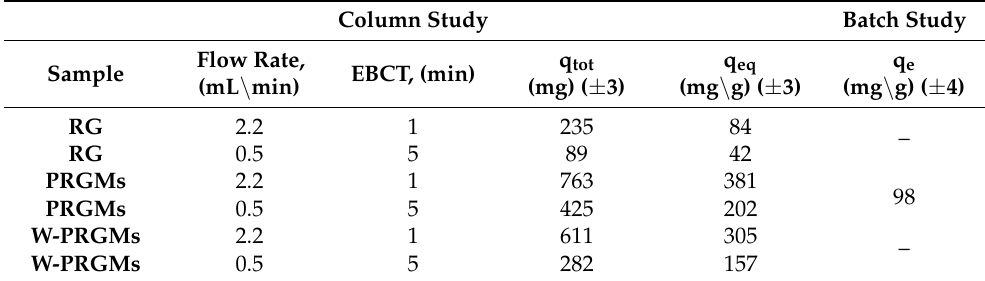
Table 4. The breakthrough curve models with their parameters.